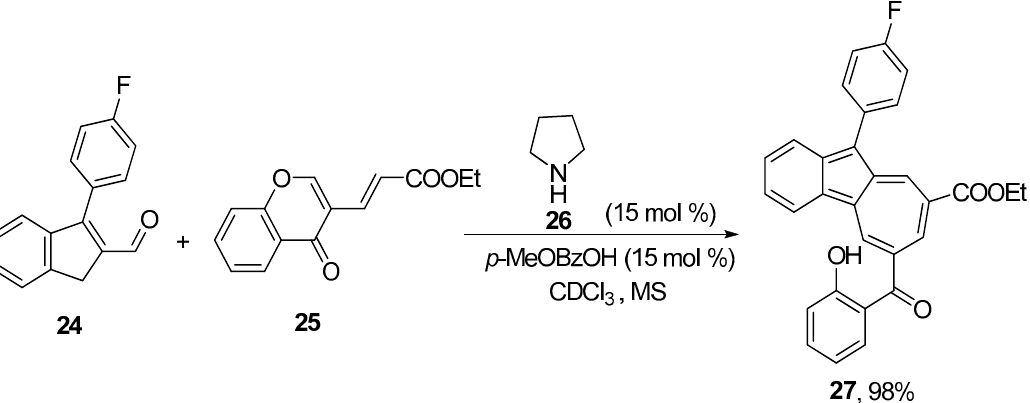
Scheme 9. Synthesis of polysubstituted azulenes 27 via reaction of substituted indene 2-carbaldehyde 24 with chromen-4-one 25